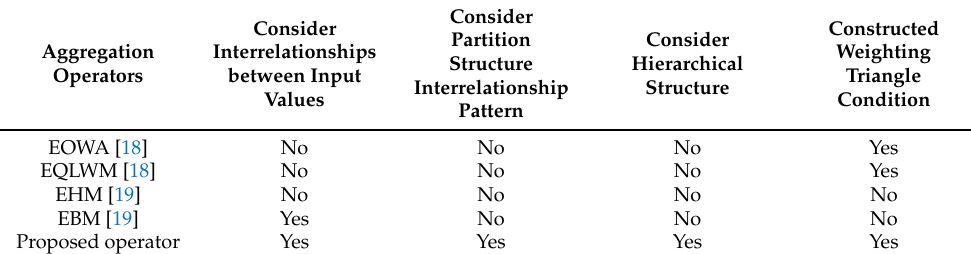
Table 4. The characteristics of different aggregation